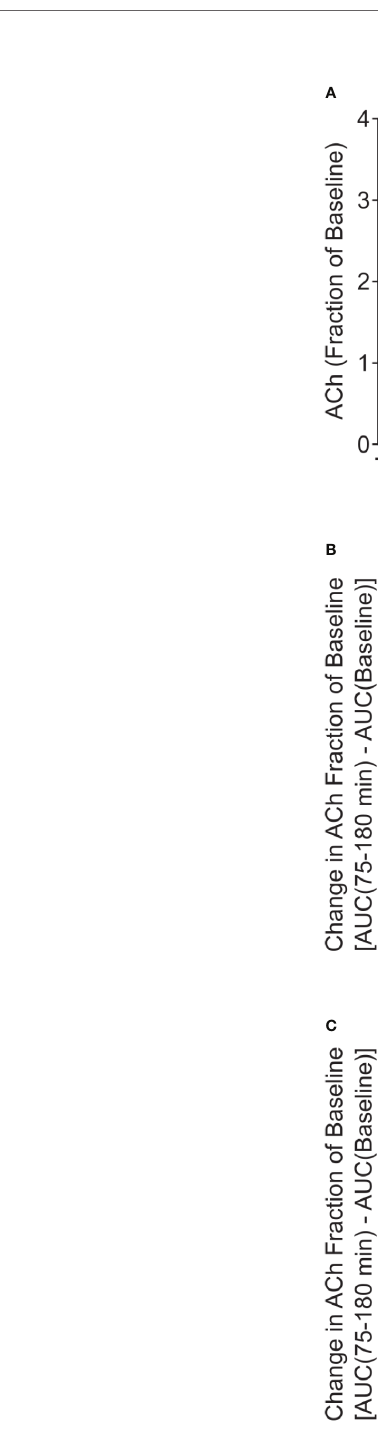
FIGURE 1 | Acetylcholine following administration of PF-6142 in rat and mouse. Acetylcholine levels in the rat prefrontal cortex (PFC) following subchronic dosing with PF-6142. (A) Time course data comparing the effect of vehicle or PF-6142 (10 mg/kg, SC) on ACh levels in the rat PFC after repeated dosing for 5 d. (B) 75 – 180-min total area under the curve of time course data. Points represent the mean + SEM, One-way ANOVA with Dunnett ’ s post-test adjusted *p < 0.05, **p < 0.01 vs. vehicle. N = 7 – 8. (C) wild-type (WT) and D1 KO mouse acetylcholine levels in the PFC. 75 – 180-min total area under the curve (AUC) data for WT and D1 KO mice treated with PF-6142 (10 mg/kg, SC) and SCH-23390 (0.32 mg/kg, SC). Two-way ANOVA with Tukey ’ s post-test adjusted *p < 0.05, **p < 0.01 vs. vehicle + vehicle within genotype. N = 6 –